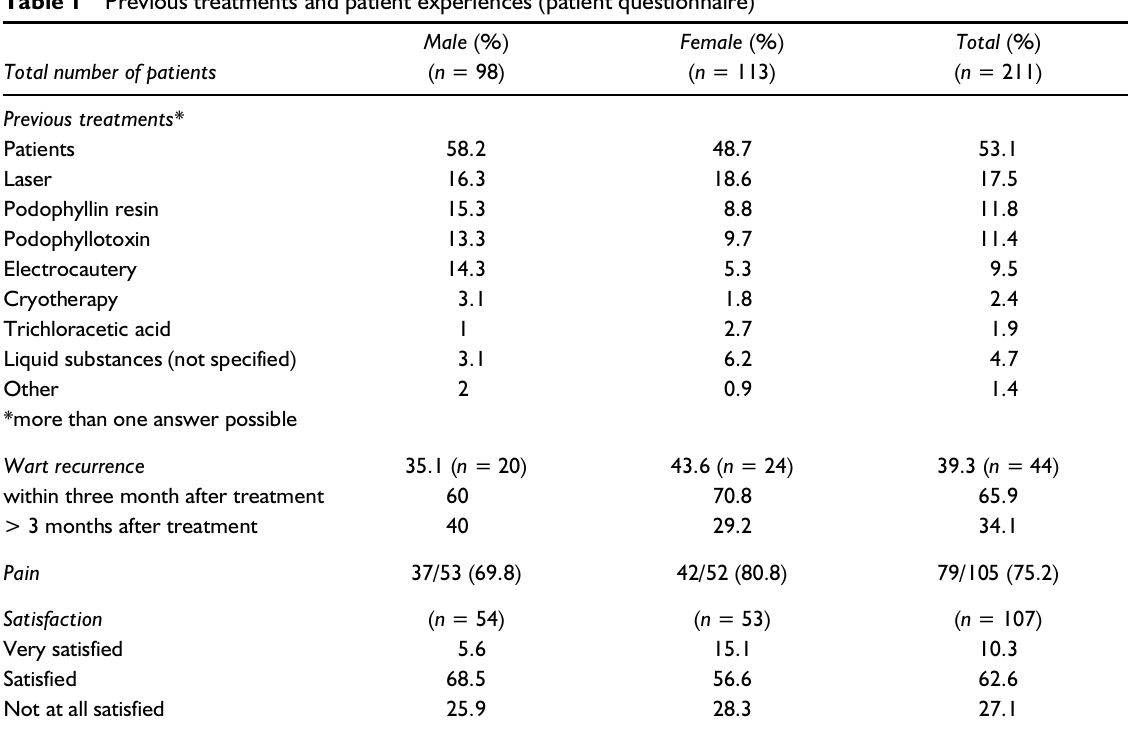
Table 1 Previous treatments and patient experiences (patient